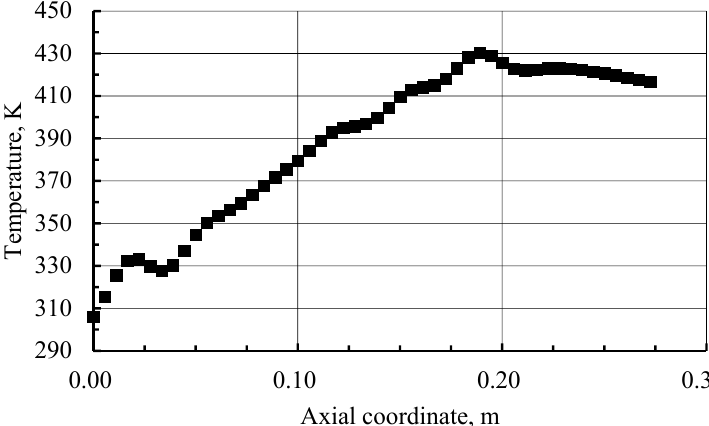
Figure 2. Wall temperature profile.